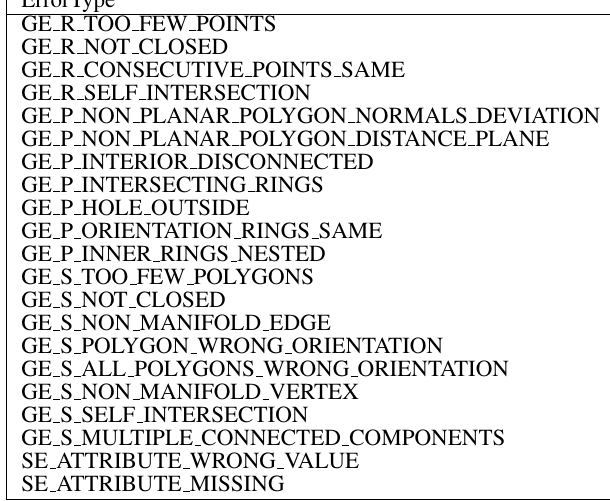
Table 3. Possible error